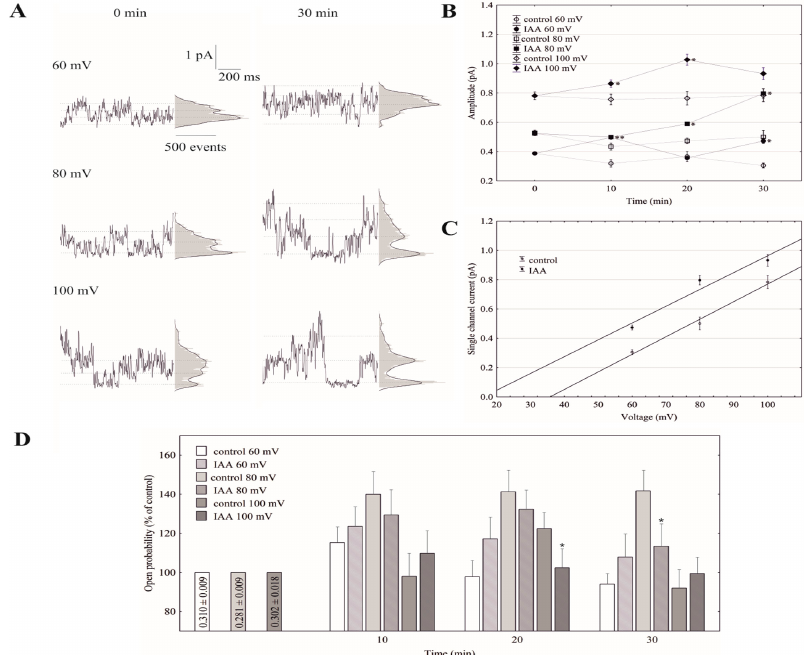
Figure 4. Effect of auxin on the single-channel activity in red beet taproot vacuoles. ( A ), The representative single-channel activity of the outside-out patch in symmetrical 100 mM KCl and in the absence ( − IAA) and presence (+IAA) of auxin at 1 µM is shown. The current traces after 30 min are shown at the different membrane voltages that are indicated as adjacent to the traces. The dotted lines indicate the closing state and different opening ones. In this patch, there are at least three channels opening. The corresponding amplitude histograms are shown to the right of the current traces. ( B ), The current–voltage relationships of the FV single-channel current amplitudes that were obtained with and without auxin as a function of time. The values of the current were obtained as the differences of the maximum of the current histograms, and represent the open and closed states of a channel, respectively. The data points are the means (±SE) from at least six independent experiments. The data failed normal distribution (Shapiro–Wilk test, p > 0.05) hence, statistical differences between IAA and the control in the same time and voltage were tested using the non-parametric Mann–Whitney U -test (asymptotic significance two-tailed, p < 0.05). Asterisk (*) indicates a significant difference. ( C ), The current–voltage characteristics for single FV channels in the control bath and in the presence of IAA. Points were obtained from the experiments shown at 30 min in ( B ). As can be seen, IAA did not change the slope of simple linear regression, expressing the single channel conductivity. ( D ), The open probability of the FV single channels (expressed as % of control) is shown as a function of voltage and time. The open probability was calculated (using FitMaster software, see also [26]) as the sum of the channel open times in the current traces normalized to the total time of the traces divided by the number of active channels in the patch. The data points are the means (±SE) from seven independent experiments. The normal distribution was confirmed by the Shapiro–Wilk test ( p > 0.05). The statistical differences of open probability values between control and IAA variants in the same time and voltage were analyzed using independent samples t -Test ( p < 0.05). Asterisk (*) indicates significant difference.